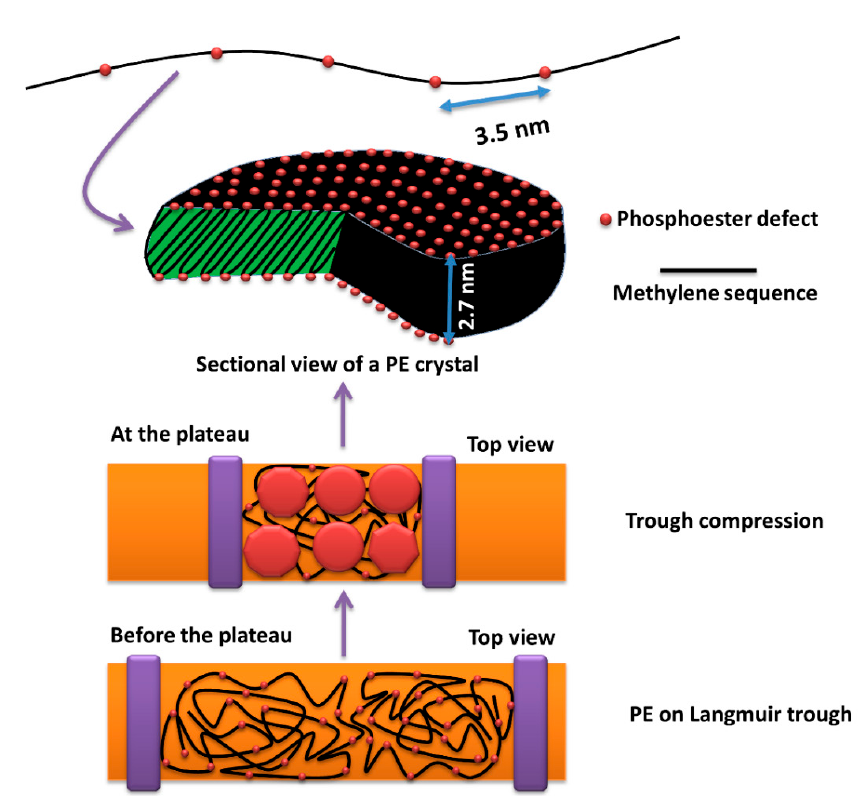
Figure 8. Schematic illustration of the chain organization of Ethoxy-PPE at the air–water interface during compression.